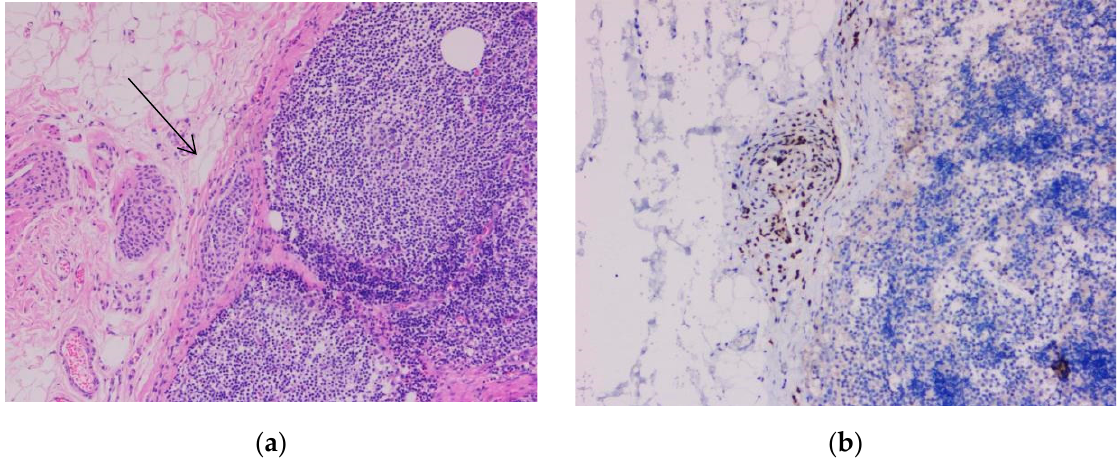
Figure 12. Capsular nevus. ( a ) Melanocyte proliferation in the lymph node capsule. The cells are round or ovoidal in shape, with eosinophilic cytoplasm and round nuclei located in the center of the cell (arrow). ( b ) Nuclear immunostaining with marker SOX10, showing the melanocytic cells aligned in the lymph node capsule. Both images were taken at 10× magnification. (Collection of Pathology Department SCJ Mure ș ).